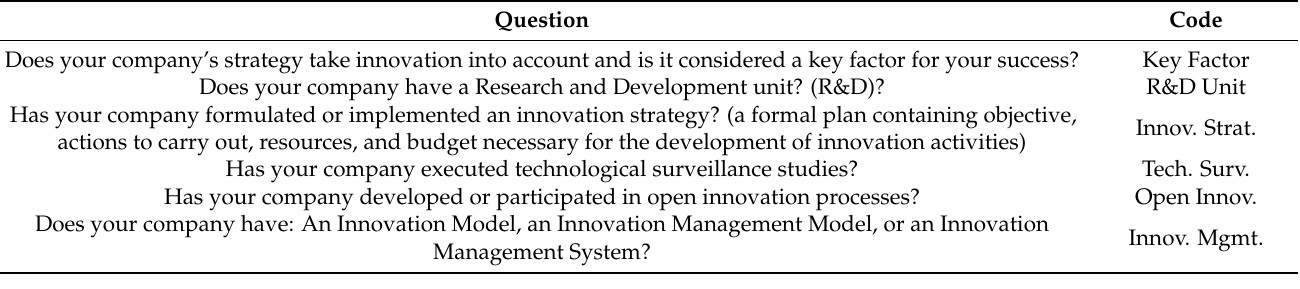
Table 5. Questions about general innovation competencies.